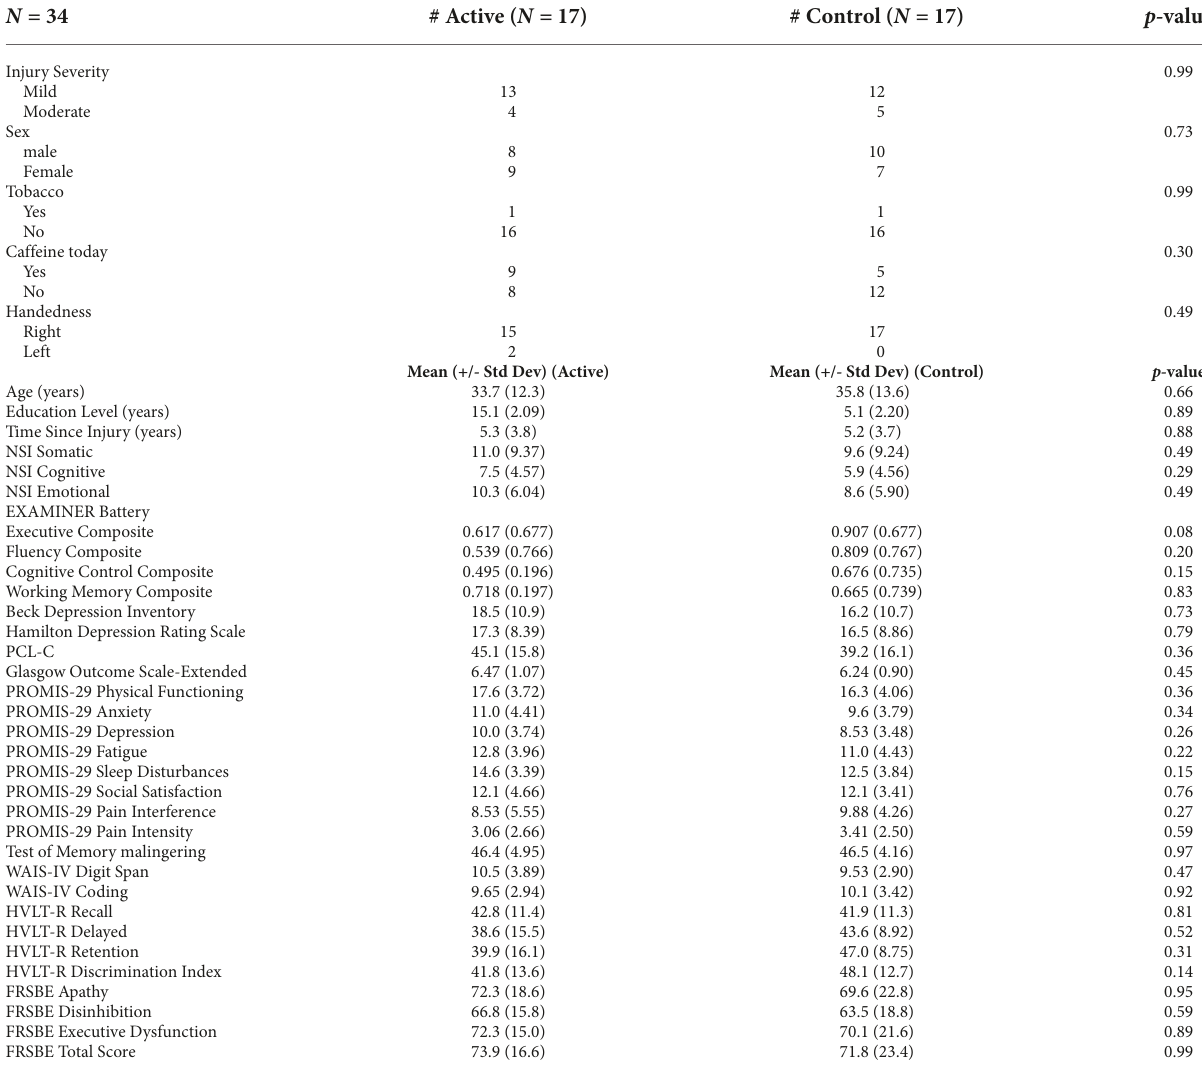
TABLE 2 Baseline demographic and cognitive performance characteristics of the sample. N = 34 # Active ( N = 17) # Control ( N = 17) p -value Injury